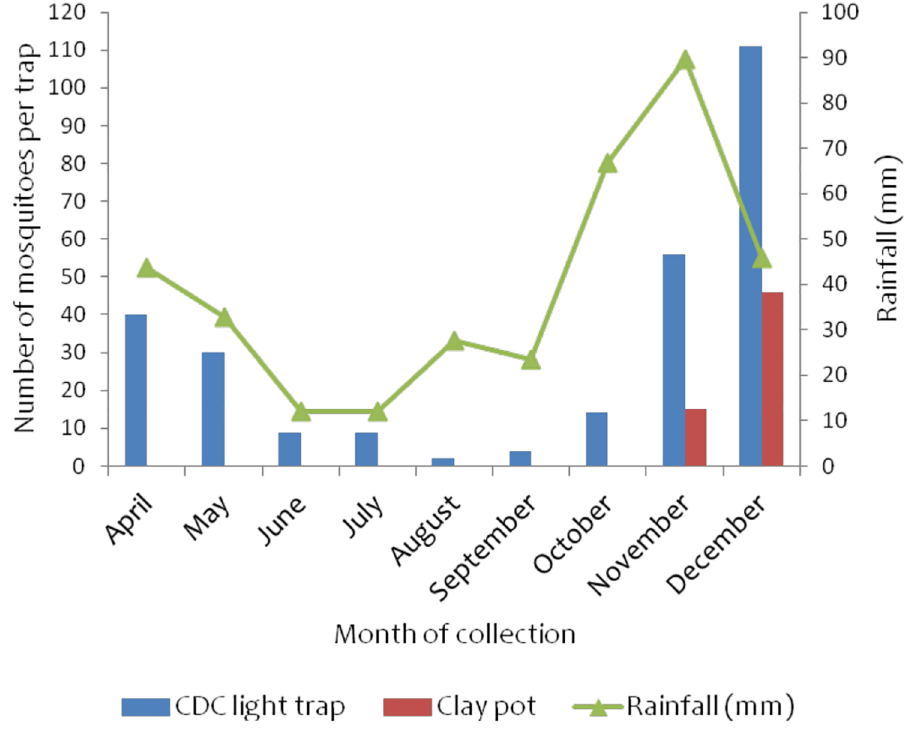
Fig 6. Monthly collection of anopheline mosquitoes in Bukindo village, Ukerewedistrict monitored using CDC light traps and clay pot methods. The rainfalldata was obtained from climate data library (http://iridl.ldeo.columbia.edu/maproom/).